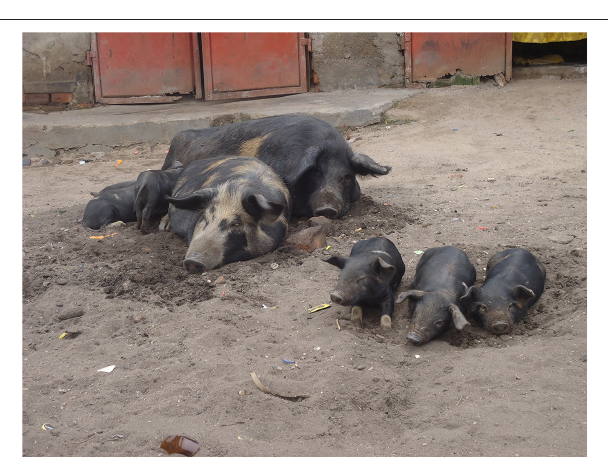
FIGURE 4 | Free-ranging pig in Uganda (picture credit: Michel Dione, ILRI).